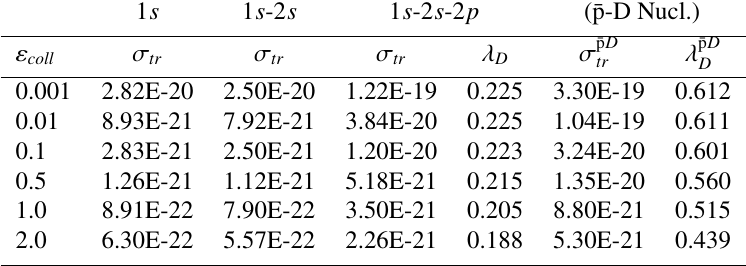
Table 1. Total ¯pD-atom formation cross sections σ tr ( ε coll ) and rates λ D in the three-body reaction (2), where α = 1 s and ε coll is the collision energy (eV). The rate is a product of the formation cross sections and the corresponding center-of-mass velocities v cm between ¯p and D µ in the input channel. The results are represented in the framework of di ff erent close-coupling approximation models, Eq. (6). The cross section σ tr is given in cm 2 and λ D in m.a.u. Results with inclusion of the strong nuclear interaction between ¯p and D are represented only in the six-state model. Our rates λ D are multiplied by factor of 5. 1 s 1 s -2 s 1 s -2 s -2 p (¯p-D